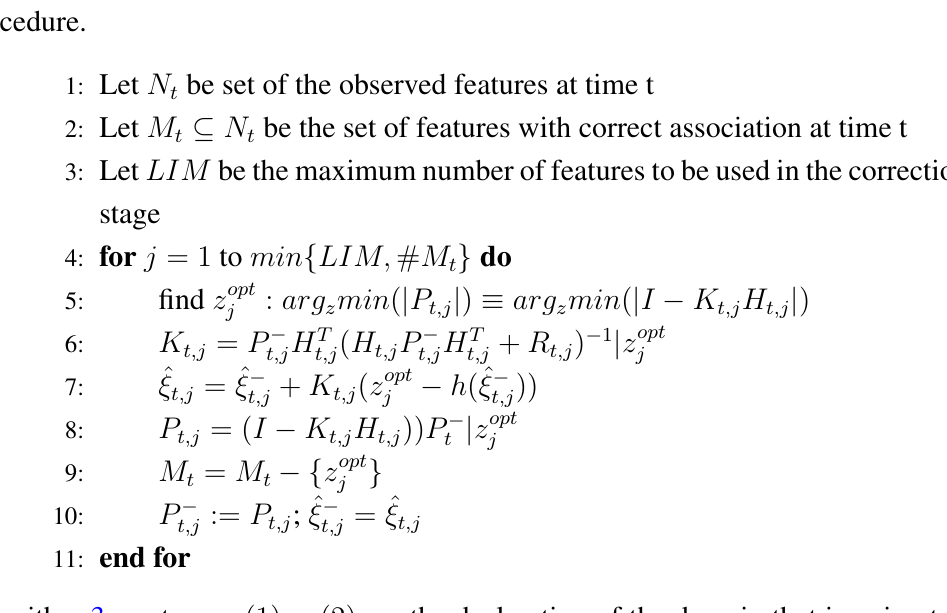
Algorithm 3. Algorithm of the EKF-SLAM based on the covariance ratio feature selection